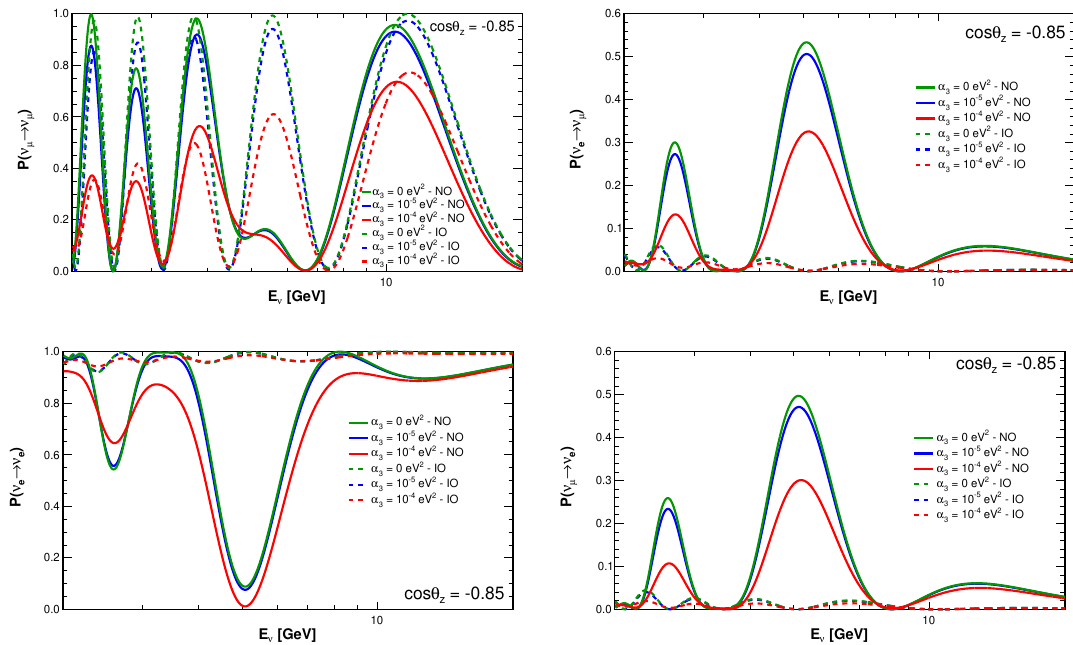
Figure 2. Muon neutrino survival (top left), transition to muon neutrino (top right), electron neutrino survival (bottom left) and transition to electron neutrino (bottom right) probabilities as a function of energy at a cosine of the zenith angle cos θ z = − 0 . 85 . Three values of the decay constant are considered: α 3 = 0 (green), α 3 = 10 − 5 eV 2 (blue) and α 3 = 10 − 4 eV 2 (red). The solid (dashed) curves are for NO (IO). Antineutrino probabilities can be described by the same curves but swapping the orderings.